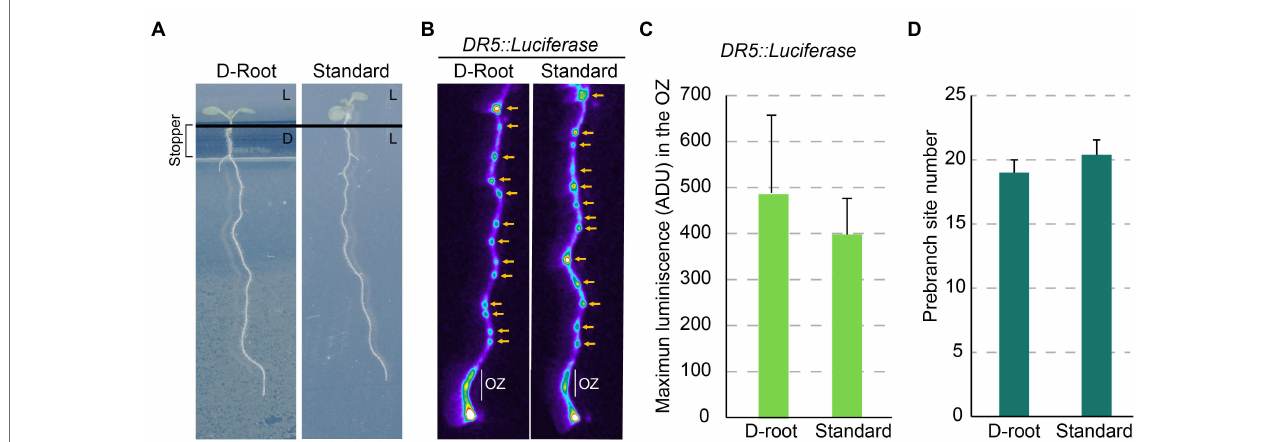
FIGURE 2 | Light perceived in the root does not affect the Root Clock activity. (A) 7 dpi plants grown in the D-Root system and under standard conditions. L: plate section exposed to light, D: plate section maintained in the dark. (B) DR5::Luciferase imaging of roots grown in the D-Root and under standard conditions. Yellow arrow: PBS. (C) DR5::Luciferase quantification in the OZ of roots in the D-Root and under standard conditions. ADU: Analog-Digital Units (D) Number of PBS formed at 7 dpi in the D-Root and under standard conditions. No statistical significance by Student’s t -test (value of p <0.05) was observed ( n =